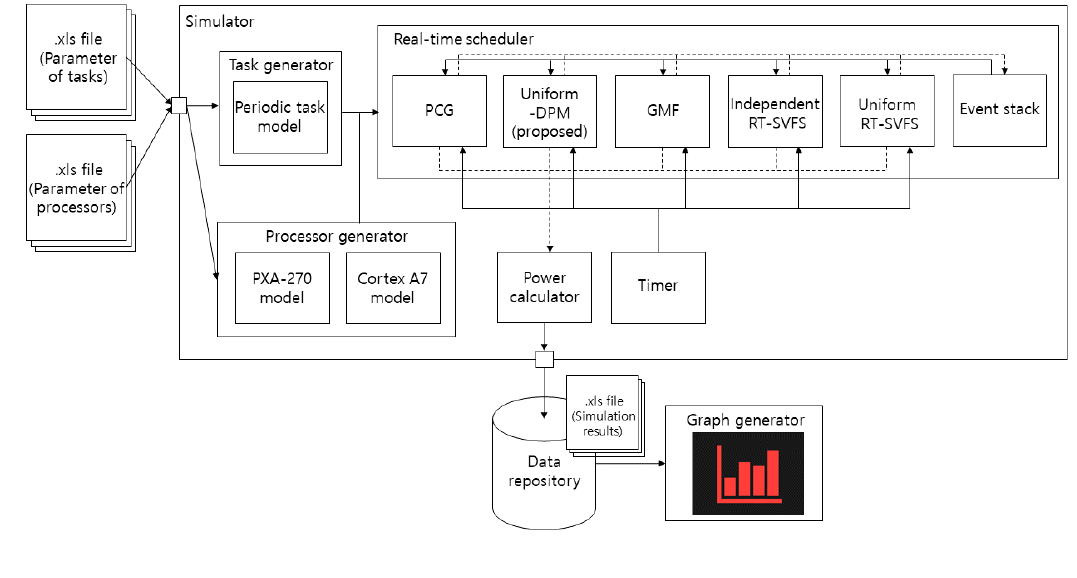
Figure 5. The architecture of the simulator.